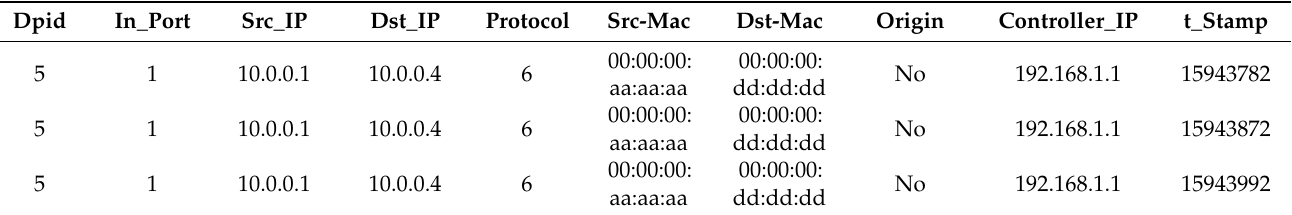
Table 4. IP traceback table for S5 in control domain